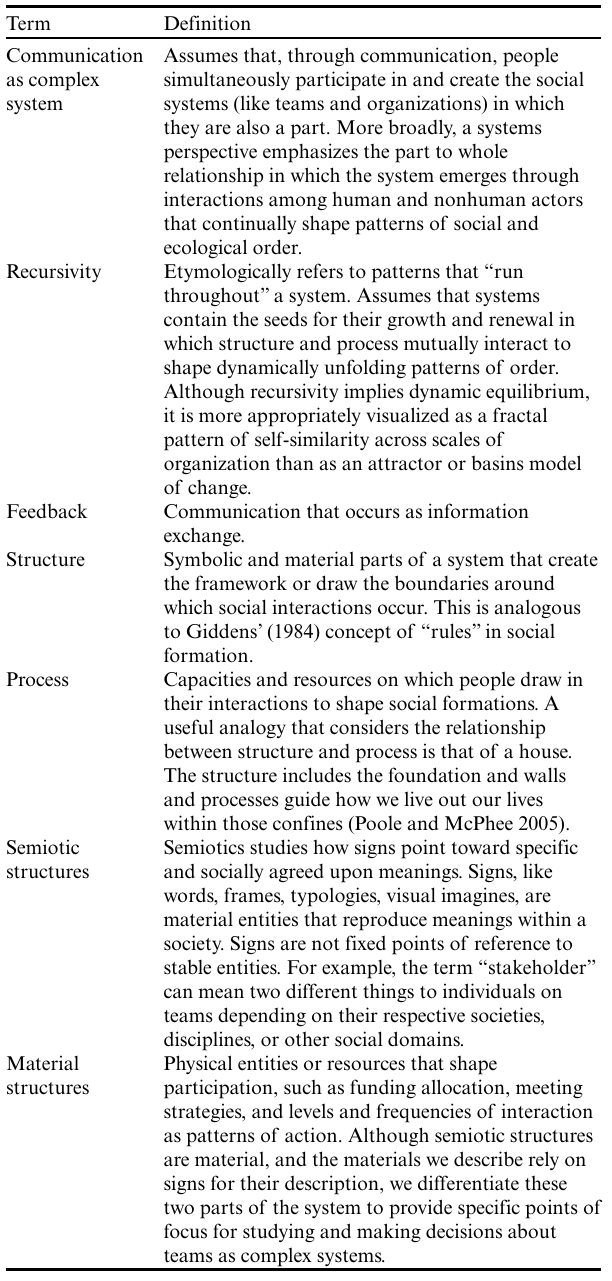
Table 1 . Glossary of communication systems